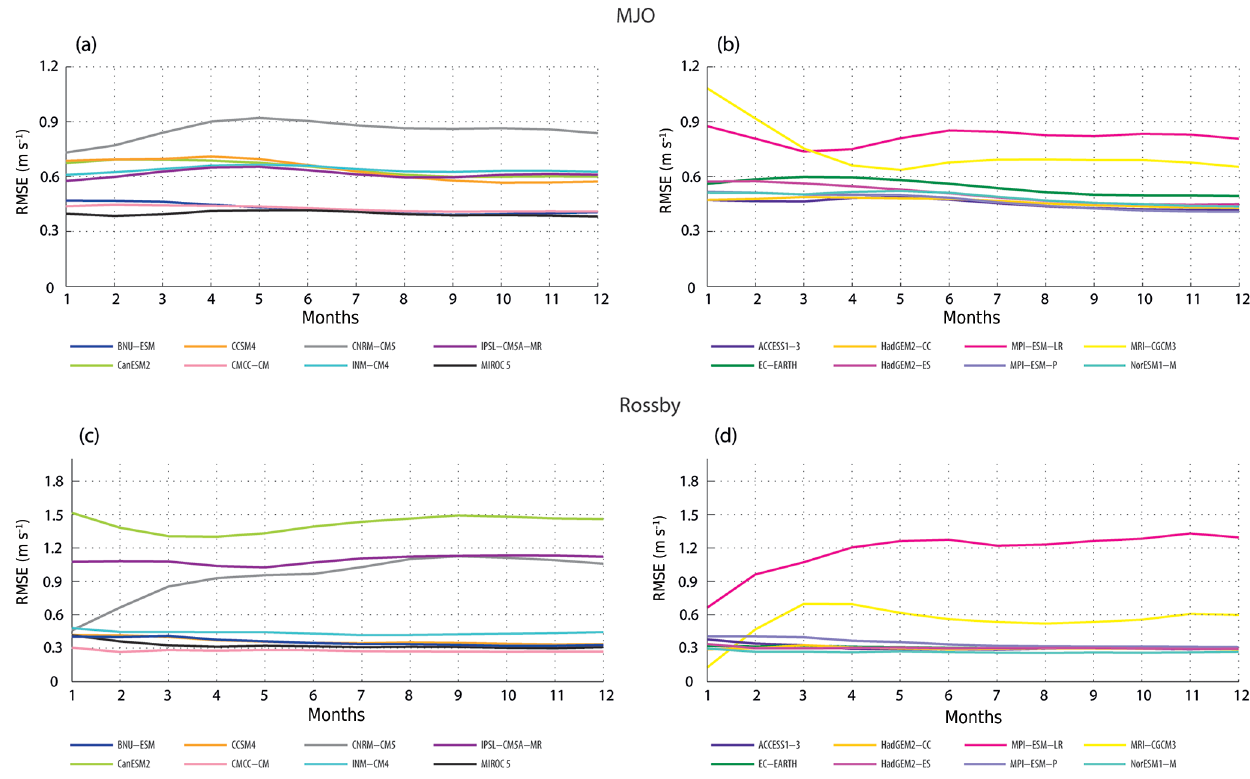
Figure 6. Root mean square error (RMSE) between modelled and observed seasonal variance of MJO (a, b) and Rossby waves (c, d) averaged zonally over the tropical Pacific (120 ◦ E–90 ◦ W) and meridionally over 5 ◦ S–5 ◦